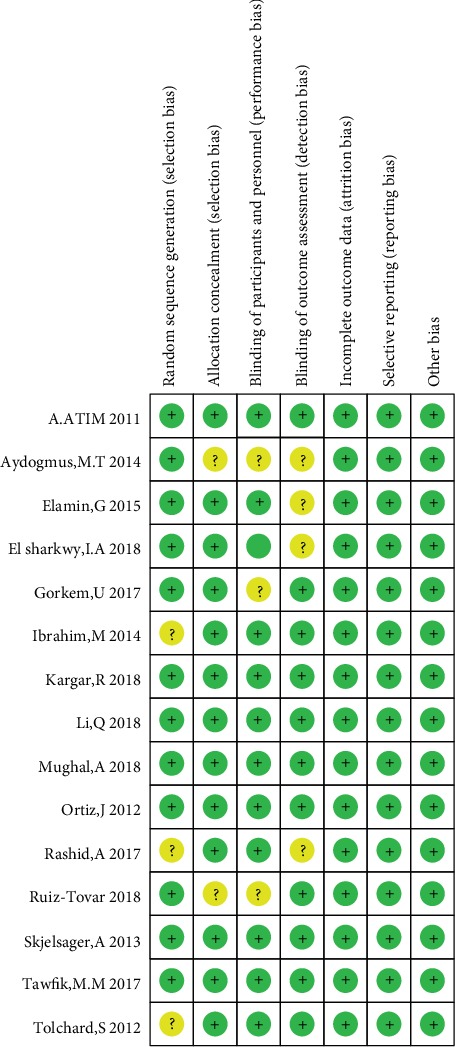
Risk of bias summary for the included studies. Green indicates low risk of bias; yellow indicates unclear risk of bias.